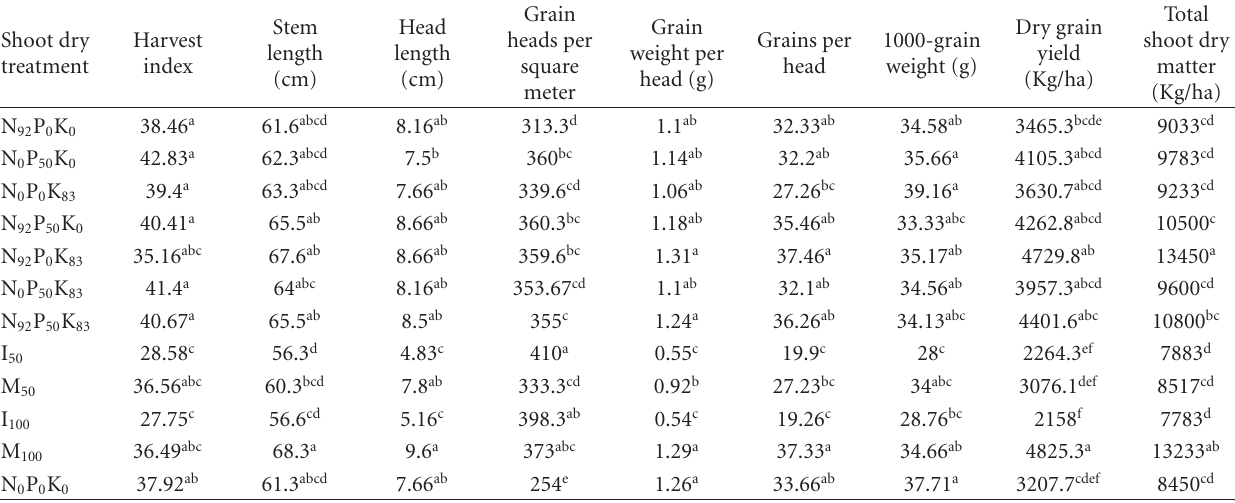
Table 2: Harvest index, grain components (stem length, head length, heads per square meter, grains weight per head, 1000 grains weight), grain yield, and the total shoot dry matter. Shoot dry